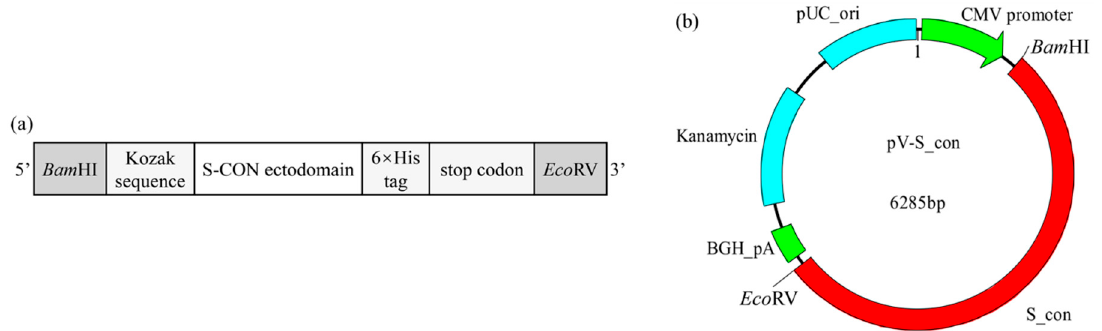
Figure 1. Schematic diagram of the S_con gene and infectious bronchitis virus (IBV) DNA vaccine (pV-S_con) plasmid. ( a ) The S_con gene. The Kozak sequence (GCCACCATGG) and 6 × His-Tag gene were added to ensure its correct expression in a eukaryotic expression vector and enable detection, respectively. ( b ) The pV-S_con plasmid. The S_con gene was inserted into the pVAX1 vector between the multiple cloning sites Bam HI and Eco RV.